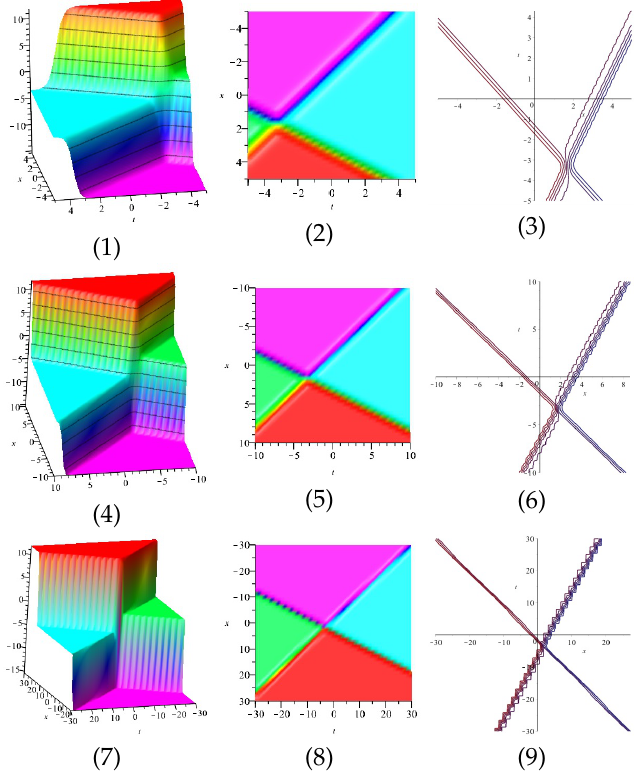
Figure 4. The 3D and 2D with the diagram of equation u 2,2 , in three different